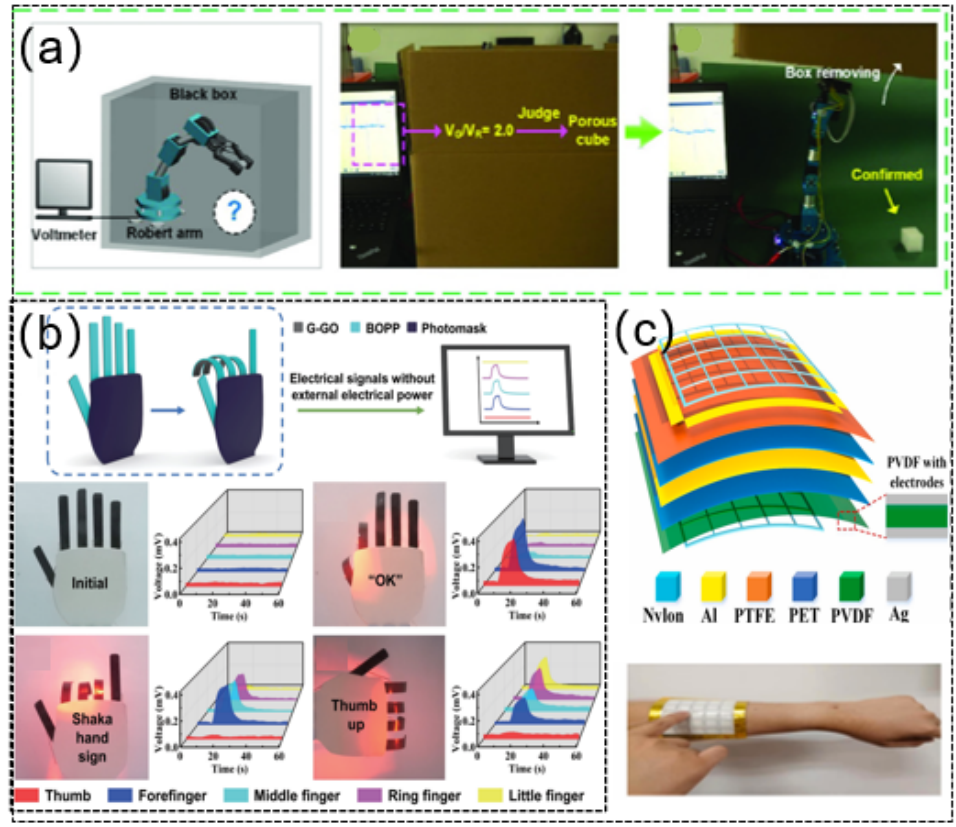
Figure 11. ( a ) Perception and learning function of intelligent prosthesis. Reprinted from Ref. [147]. ( b ) Bionic five-fingered hand. Reprinted with permission from Ref. [148]. Copyright 2021 Springer. ( c ) Schematic diagram of human–machine interface applied to arm. Reprinted with permission from Ref. [150]. Copyright 2021